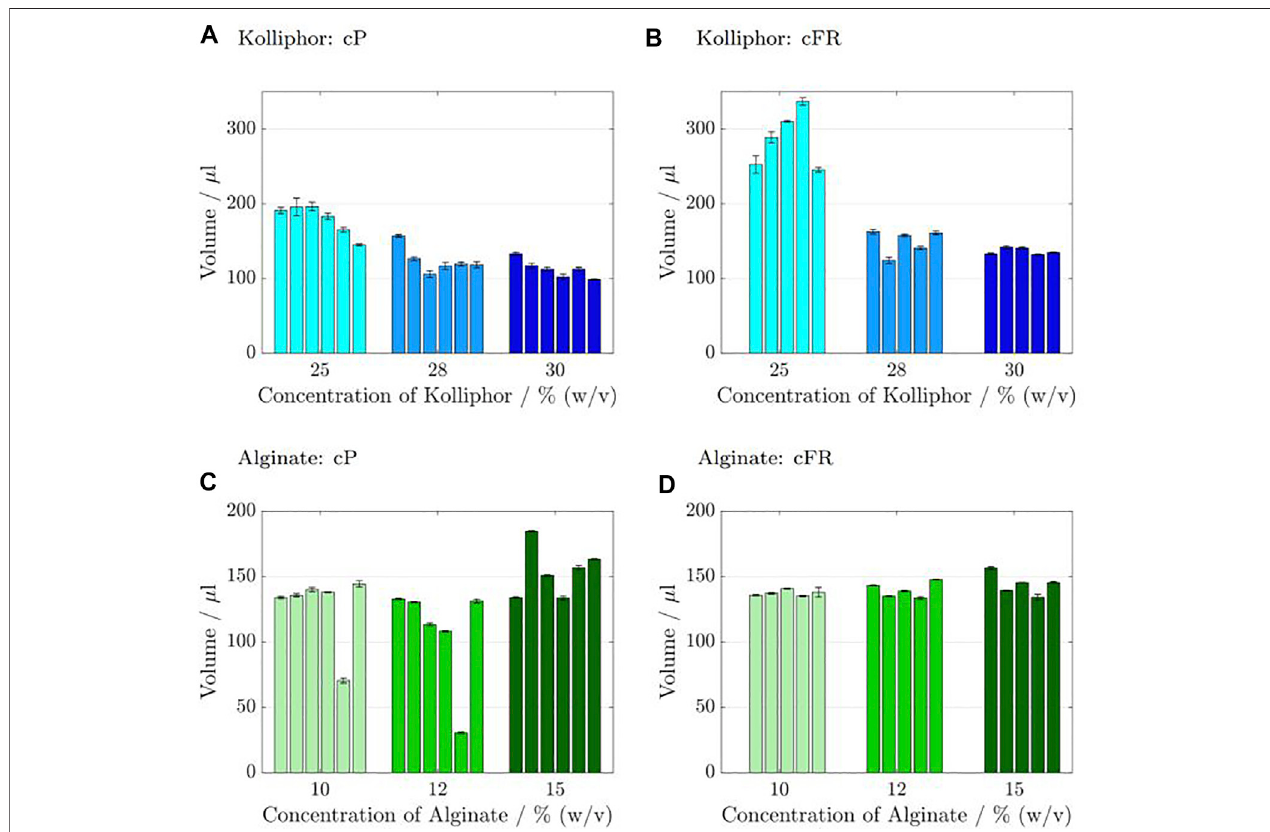
FIGURE7 | Results of the reproducibility tests for Kolliphor containing inks (A – B) and Alginate containing inks (C – D) . Sixruns ( n run =6) were carried out in which 3 samples ( n sample = 3) were printed each for the cP and the cFR approach. Consequently, 18 cylinders for the cP approach and 18 cylinders for the cFR approach were printedintotal.Theobtainedmeanvaluesanddeviationsofthe3samplesbelongingtoonerunareshownin1 bar.ThecPresultswherethepressurewaskeptconstant forallsixrunsarepresentedin (A,C) ,andthecFRresultswherethepressurewasadaptedtosetaconstant fl owrateareshownin (B,D) .Asthe3samplesfromrun 1 with cFR were used as calibration set for the fl ow rate determination, there is 1 bar